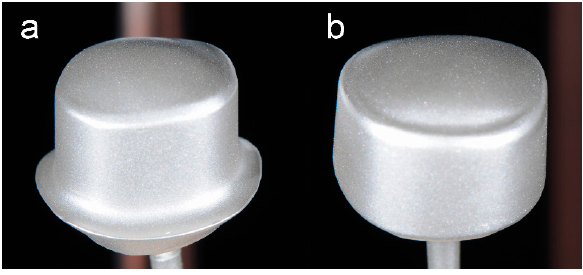
Figure 3. Primary crowns of ( a ) 0°; and ( b ) 2° on copper sticks, air brushed with silver conductive lacquer.